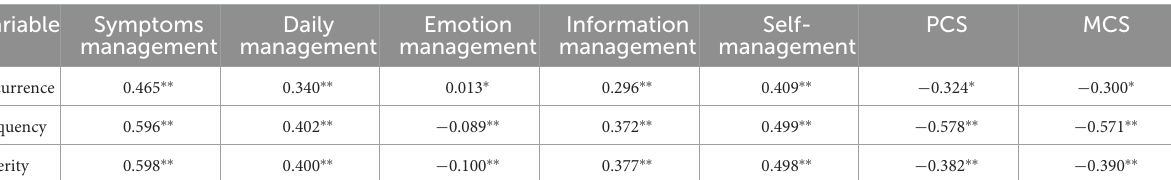
TABLE 4 Correlations of major study variables ( n =